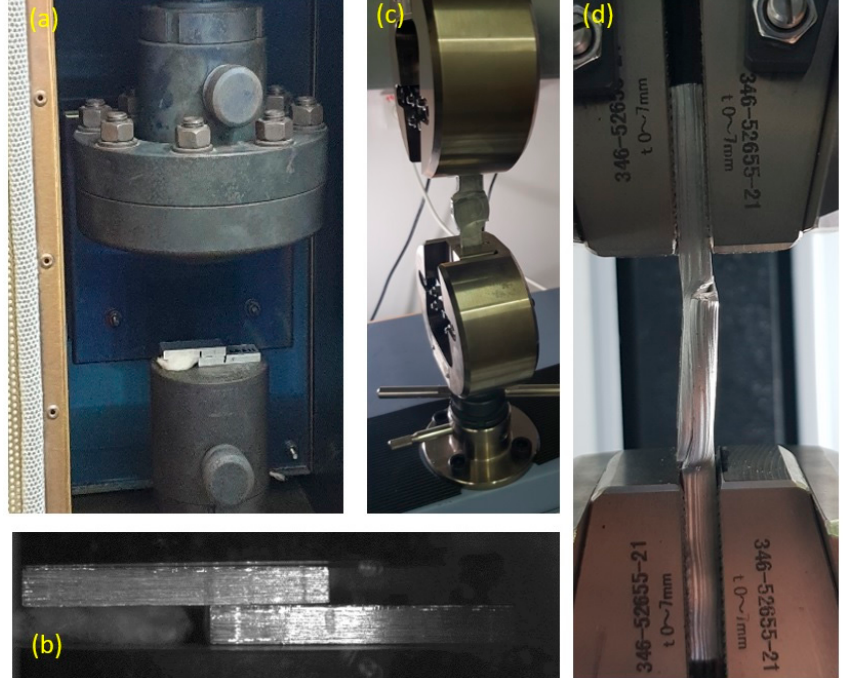
Figure 1. A specimen in the compression experimental system ( a ), and initial beam configuration in the compression tests, placed within the system ( b ). A specimen in the tensile machine ( c ), also shown from a side view inside the tensile grips ( d